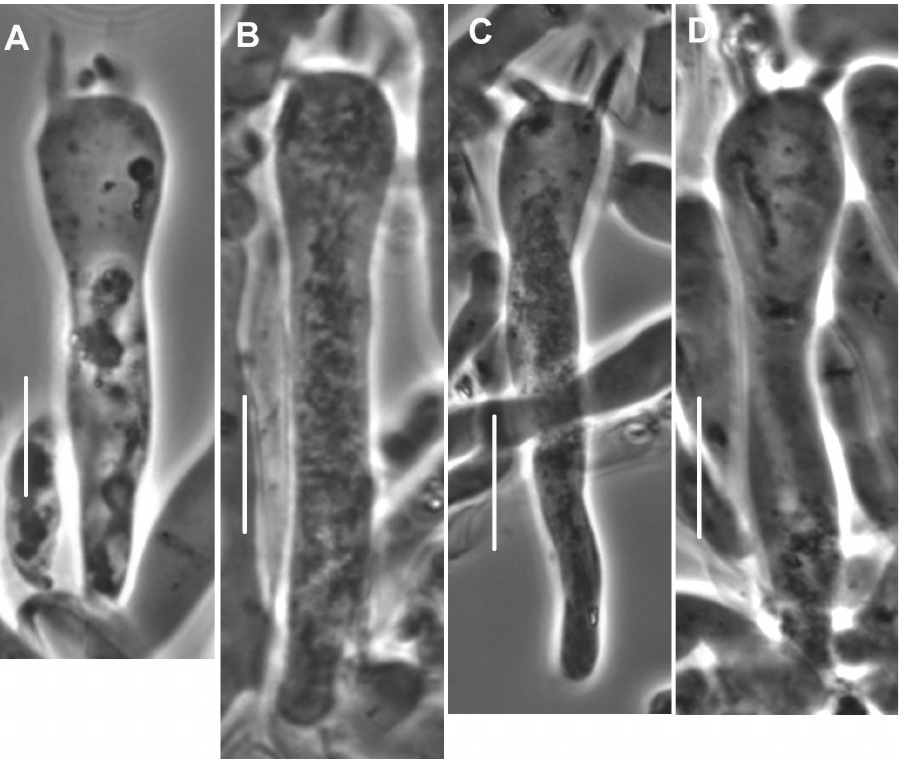
Figure 67. Mycetinis salalis . Basidia. Standard bars = 10 µm. TFB 5724 (TENN